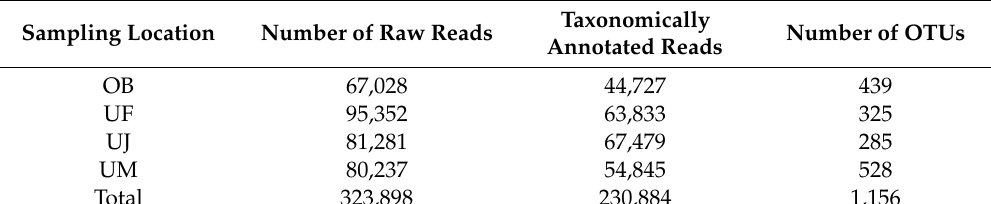
Table 3. Overview of 18S rRNA gene data.